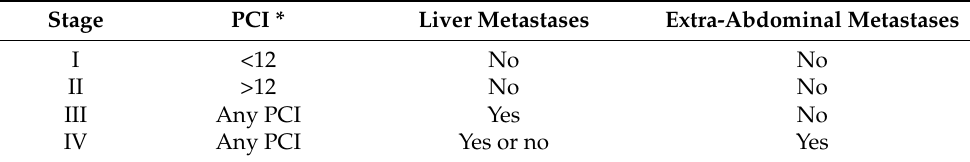
Table 1. MD Anderson Cancer Center DSRCT staging